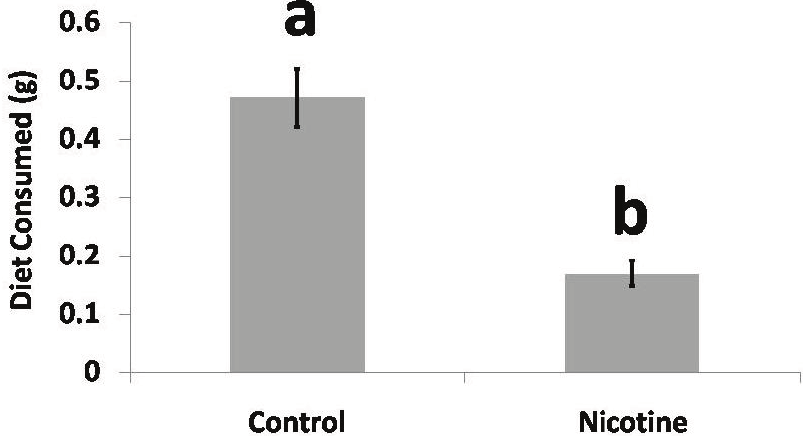
Figure 2. Diet preference bioassay. 6th instar H. zea caterpillars consumed significantly more artificial control diet than artificial diet laced with nicotine (1.5 µg nicotine/mg diet) over a 24 h observation period (N = 40, t -test, p = 8.8 × 10 − 7